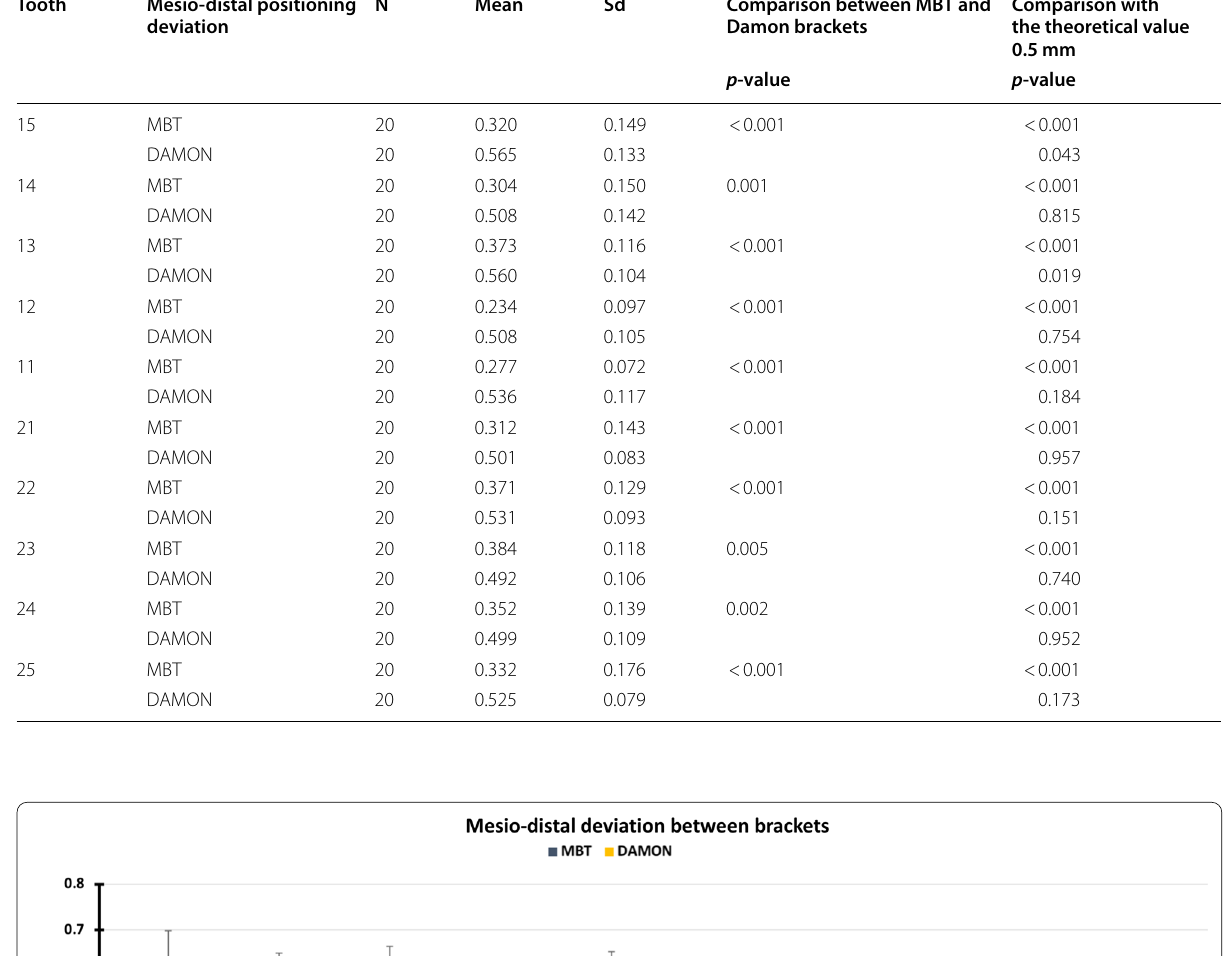
Table 3 Mean and standard deviation of the differences in mesio-distal positioning between direct and indirect methods using MBT and Damon brackets Tooth